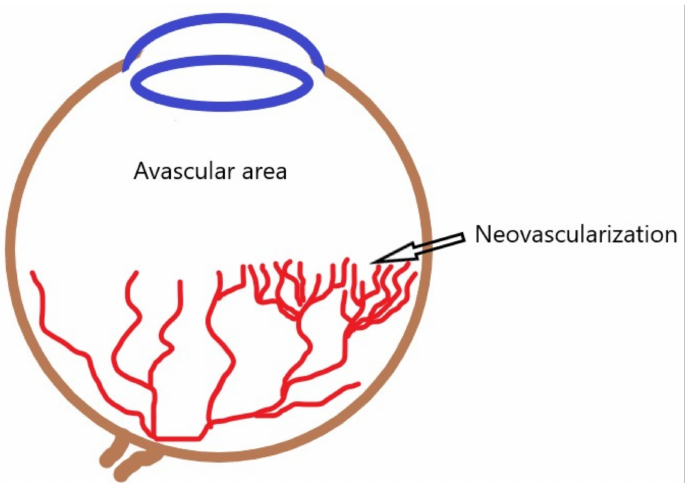
Figure 3. Schematic representation of preterm retinopathy. Blood vessel growth is inhibited by exposure to hyperoxia. The hypoxic peripheral avascular area of the retina produces angiogenic factors, leading to uncontrolled